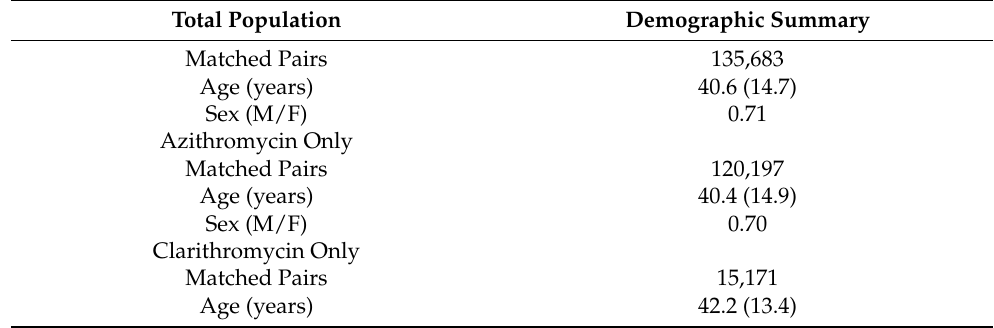
Figure 1. Summary of cohort generation for the common infections cohort ( A ) and bacterial pneumo- nia cohort ( B ) utilized in the study’s analyses. Table 1. Summary of the common acute infection study cohort demographic data in total, as well as broken down by macrolide